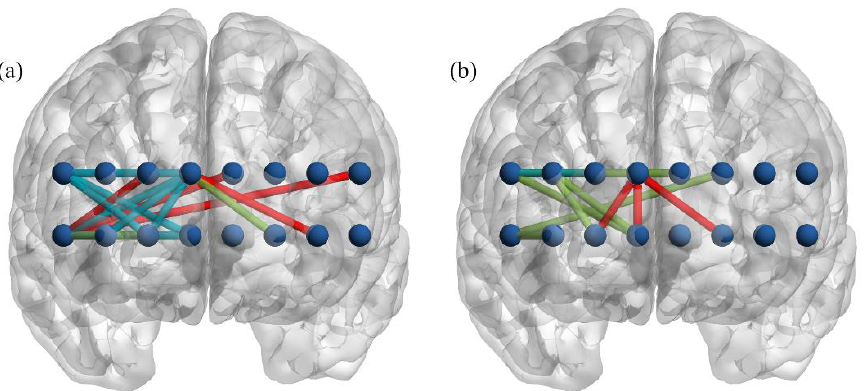
Figure 5. Connection with low correlation coefficients between conditions; ( a ) female, ( b ) male. Red: baseline – simple GNG, green: baseline – emotional GNG, cyan: both baseline – simple GNG and baseline – emotional GNG. Red: baseline–simple GNG, green: baseline–emotional GNG, cyan: both baseline–simple GNG and baseline–emotional